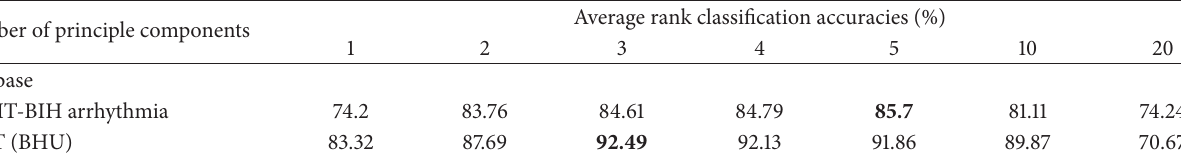
Table 1: Experimental results expressing average rank classification accuracies at different dimensions for MIT-BIH arrhythmia database and IIT (BHU) database.